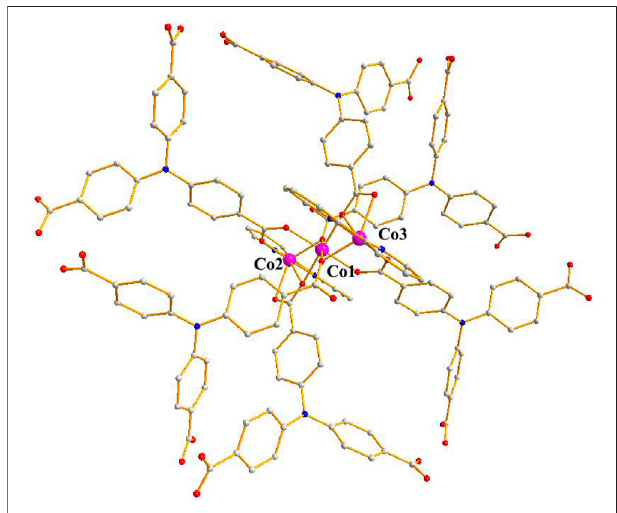
FIGURE 1 | The coordination mode of Co atoms in compound 1 (C: Gray, N: Blue, Co:Purple, O: